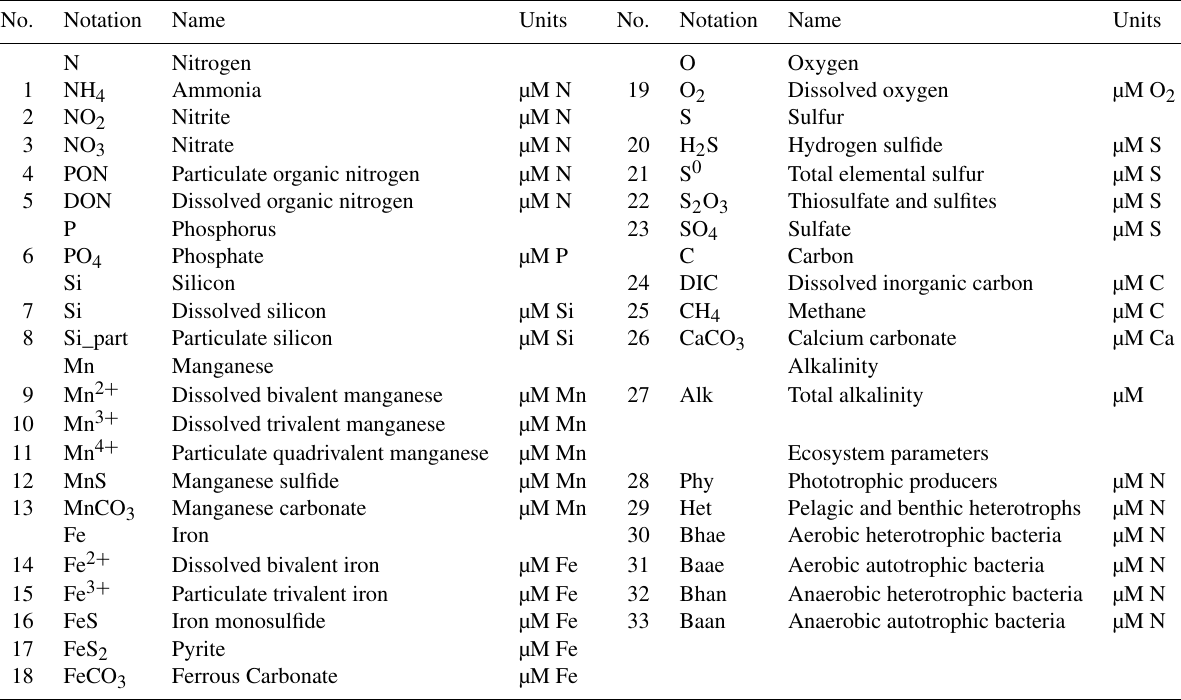
Table 1. State variables of BROM.